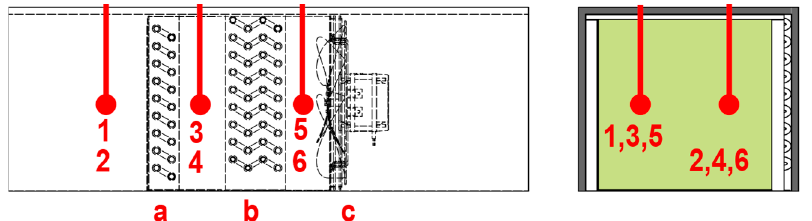
Figure 4. Location of measuring points (1–6) and components (from the left): evaporator ( a ), con- denser ( b ) and fan ( c ).